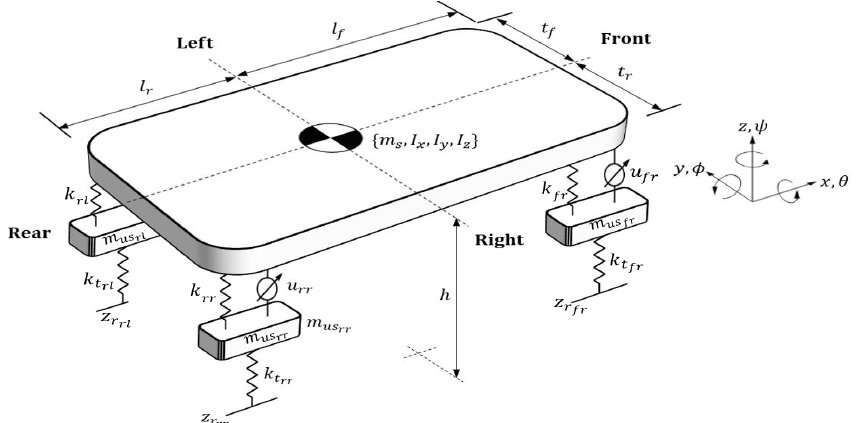
Figure 6. Full vertical vehicle